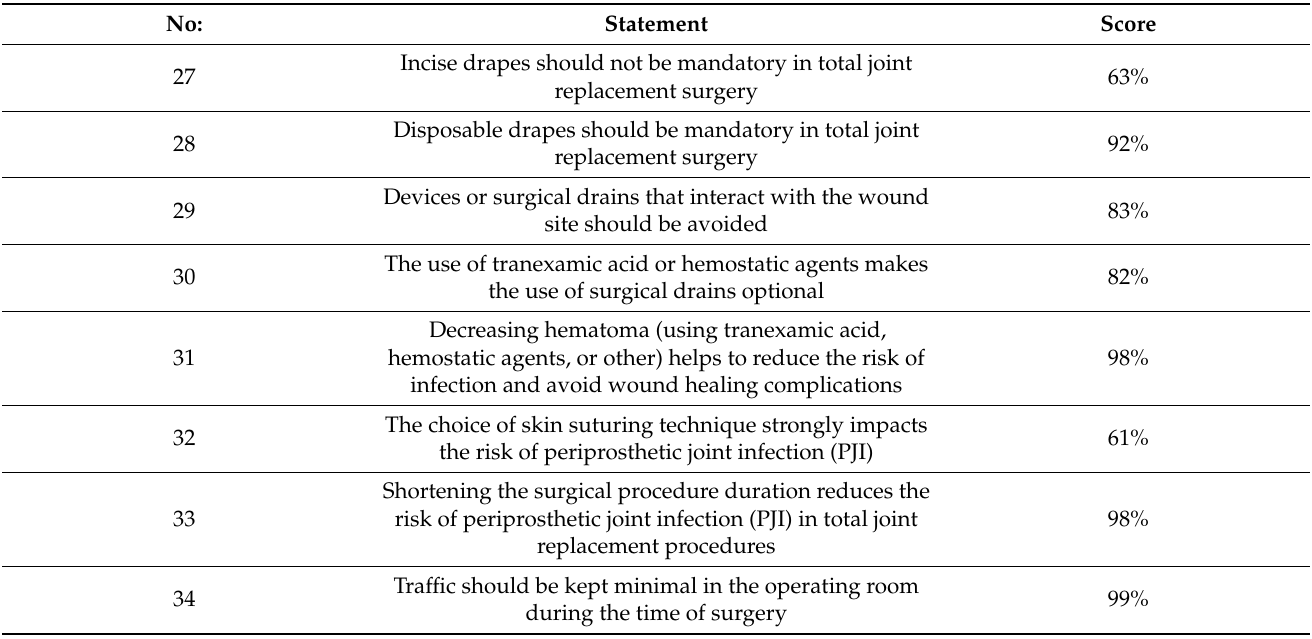
Table 4. Consensus statements and agreement scores on Domain D: other intra-operative action that could be implemented to improve the prevention of PJI.